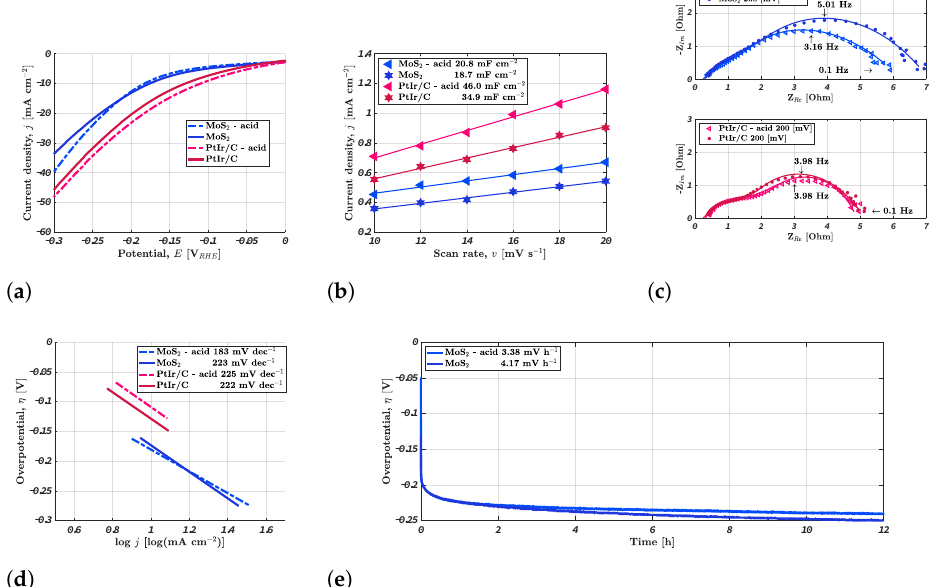
Figure 4. Electrochemical results detailing the effects of acid treatment on the resulting performance in 1.0 M KOH at room temperature. ( a ) Linear sweep voltammetry, ( b ) the electrochemical double layer, ( c ) Nyquist plots at − 0.20 V RHE , and ( d ) Tafel slopes. The stability at 10 mA cm − 2 over 12 h is shown in ( e ). All overpotentials are relative to the reversible hydrogen